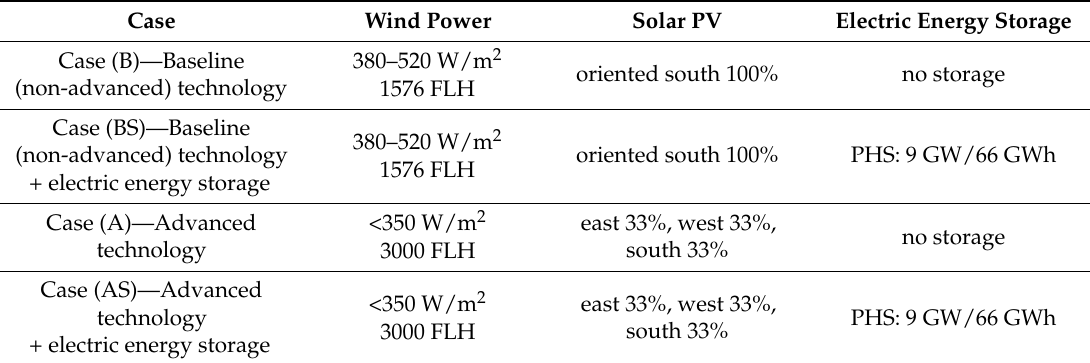
Table 1. Introduction of the four study